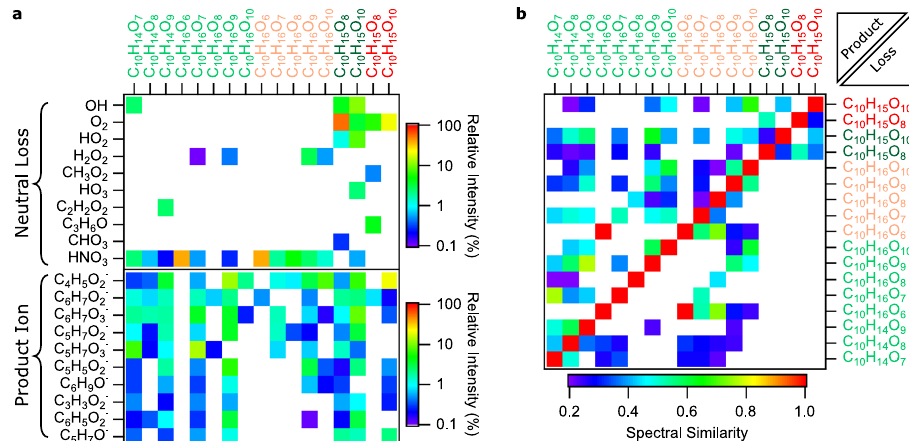
Fig. 1 Common MS/MS product ions and neutral losses observed. a Selected neutral loss patterns deduced from the formulae of the parent and product ions, and the ten most common product ions observed. b Pair-wise spectral similarities in MS/MS spectra. Corresponding MS/MS data were obtained at NCE 2 for NO 3 – adducts of limonene and α -pinene ozonolysis products. Parent molecular formulae are shown on the upper x -axis with labels for closed- shell limonene and α -pinene ozonolysis products in light green and light red, respectively. Labels for limonene and α -pinene RO 2 radical are in dark green and dark red, respectively. Inferred neutral losses and observed product ions with relative intensity ≥ 0.1% are shown in log color in a . The upper triangle and lower triangle areas in b represent the cosine similarity between the observed product ions or neutral losses, respectively, among the MS/MS spectra. For clarity, only pairs with cosine similarity ≥ 0.2 are shown in linear color scale. Parent molecular formulae are also shown on the right y -axis in b